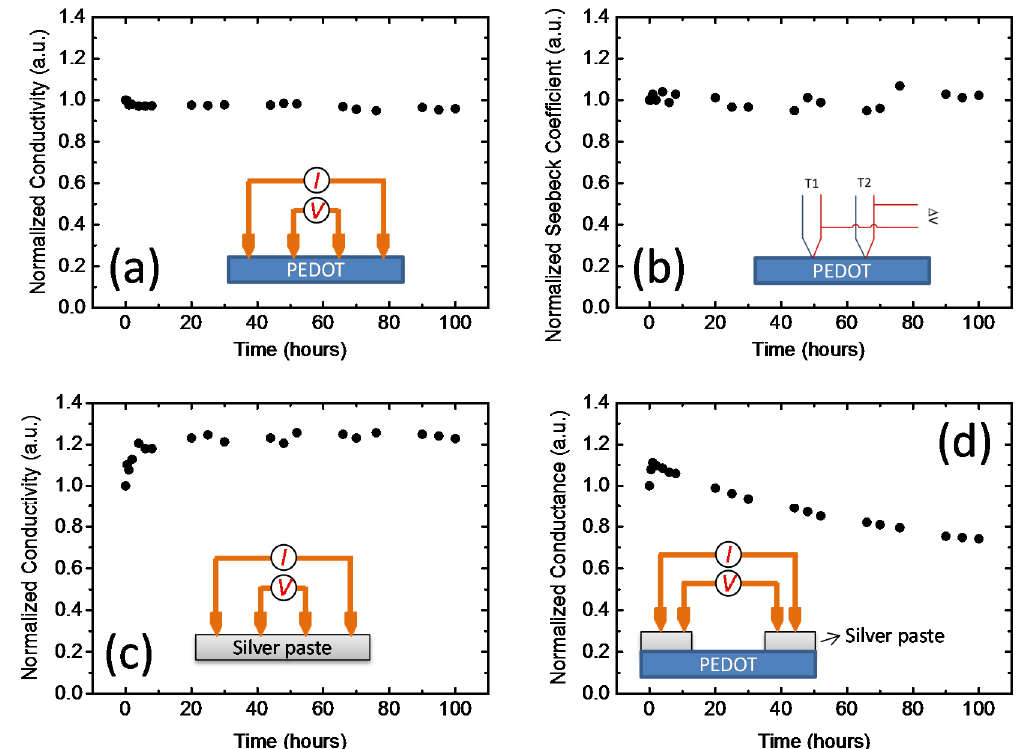
Figure 11. ( a ) Electrical conductivity and ( b ) Seebeck coefficient of PEDOT:PSS, and ( c ) electrical conductivity of silver paste and ( d ) conductance of silver paste/PEDOT:PSS/silver paste as a function of time at 80 °C. Reproduced with permission from [68]. Copyright 2014 The Royal Society of